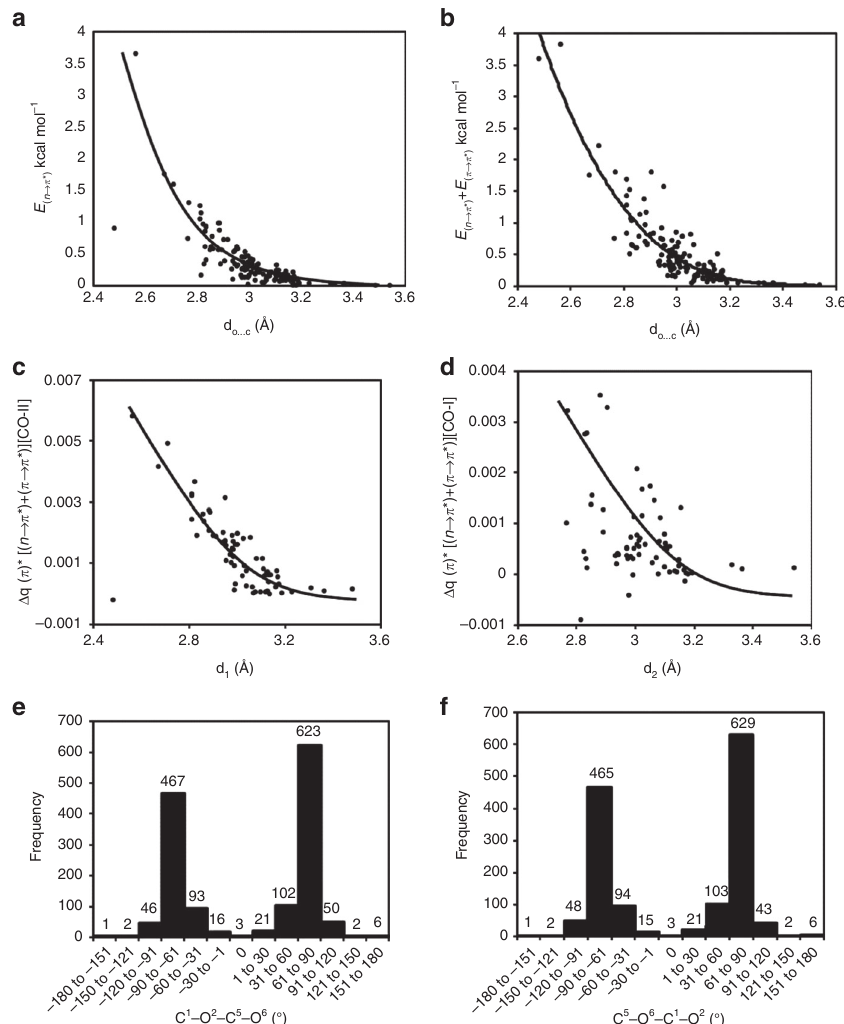
Fig. 7 Delocalization energies, charge redistribution and torsion angles. a Plot of n → π * interaction energies between the interacting carbonyl pairs against crystallographic O ··· C distances (d 1 and d 2 ) in molecules shown in Tables 1 – 3. When the x -axis is d 1 , E 1 ( n → π *) is plotted in the y -axis and when the x -axis is d 2 , E 2 ( n → π *) is plotted in the y -axis. The d 1 , d 2 , E 1 ( n → π *) and E 2 ( n → π *) values are taken from Tables 1 – 3. The n → π * interaction energies were computed at B3LYP/6-311 + G(2d,p) level of theory. b Plot of overall orbital interaction energy (sum of n → π * and π → π * interaction energies) between the interacting carbonyl pairs against crystallographic O ··· C distances (d 1 and d 2 ) in molecules shown in Tables 1 – 3. When the x -axis is d 1 , E 1 ( n → π *) + E 1 ( π → π *) is plotted in the y -axis and when the x -axis is d 2 , E 2 ( n → π *) + E 2 ( π → π *) is plotted in the y -axis. d 1 , d 2 E 1 ( n → π *) and E 2 ( n → π *) , values are taken from Tables 1 – 3. E 1 ( π → π *) and E 2 ( π → π *) values are taken from Supplementary Table 3, Supplementary Table 7 and Supplementary Table 9. The orbital interaction energies were computed at B3LYP/6-311 + G(2d,p) level of theory. c Plot of accumulation of charges on the π * C = O orbital of CO-II due to donation from lone pairs of oxygen and π π * π C = O orbital of CO-I against d 1 . d Plot of accumulation of charges on the C = O orbital of CO-I due to donation from lone pairs of oxygen and C = O orbital of CO-II against d 2 . The solid curves in a-d are drawn for convenience. e Histogram plot showing the frequency of the C 1 ═ O 2 ··· C 5 ═ O 6 dihedral angles (see Supplementary Fig. 3 for atom numbers) for 1432 molecules obtained from the CSD search. f Histogram plot showing the frequency of the C 5 ═ O 6 ··· C 1 ═ O 2 dihedral angles (see Supplementary Fig. 3 for atom numbers) for 1432 molecules obtained from the CSD search helices and β -turns. It would also be interesting to investigate if X-ray crystal structure determination method . Single crystal structures of compound 1 – 8 were determined by measuring X-ray intensity data. Bruker some non-peptidic fragments obtained from the CSD search having strong reciprocal C ═ O ··· C ═ O interactions could be used to stabilize PPII conformation or design peptide-turns. Finally, an energy decomposition analysis would provide better under- standing of the forces that contributes to the stabilization of reciprocal C ═ O ··· C ═ O interactions. Methods Crystallization method . Single crystals of compounds 1 – 8 were grown by slow evaporation. Various solvent combinations were used to crystallize the compounds either at room temperature or low temperature (4°C). Details of the crystallization conditions are given in Supplementary Table 1. NATURE COMMUNICATIONS | 8: 78 | DOI: 10.1038/s41467-017-00081-x |